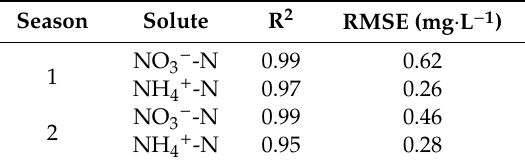
Table 3. Statistical analysis of the comparison between observed and simulated N